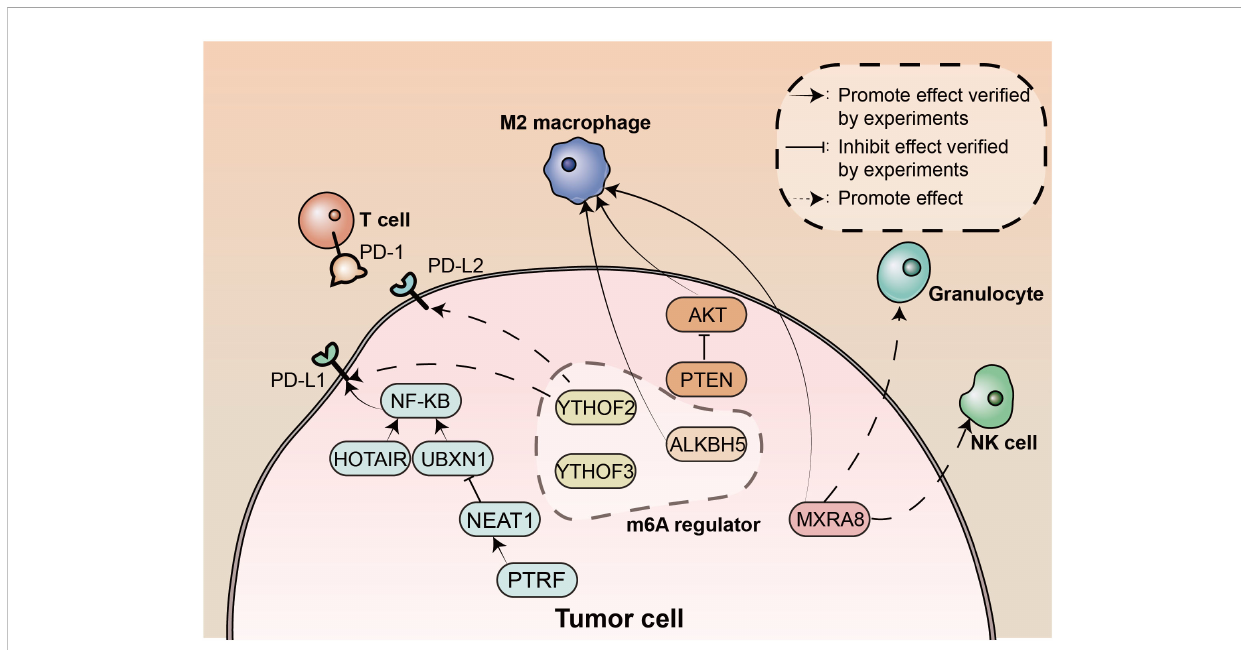
FIGURE 1 The landscape of tumor microenvironment in brain tumors. m6A, N6-methyladenosine; NK, natural killer; PD-1, Programmed death protein 1; PD- L1, programmed death-ligand 1; PD-L2, programmed death-ligand 2; PTRF, polymerase 1 and transcript release